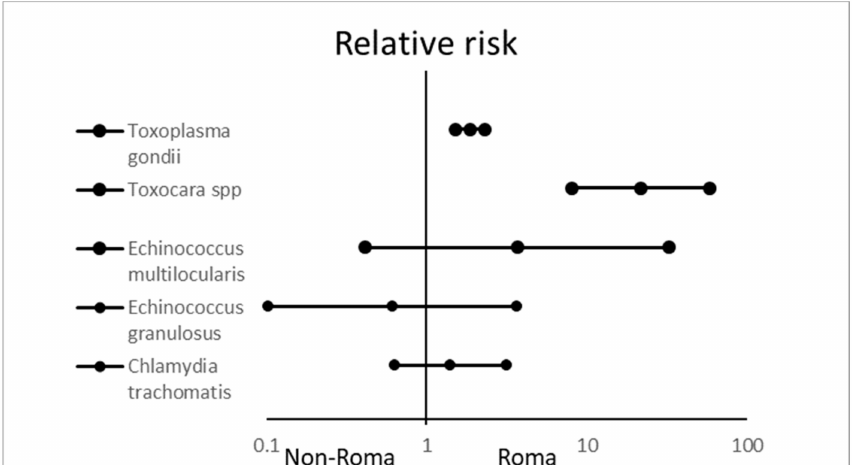
Figure 4. Relative risk with 95% confidence intervals of serological markers positivity of selected parasites and Chlamydia trachomatis in Roma participants, compared with the non-Roma